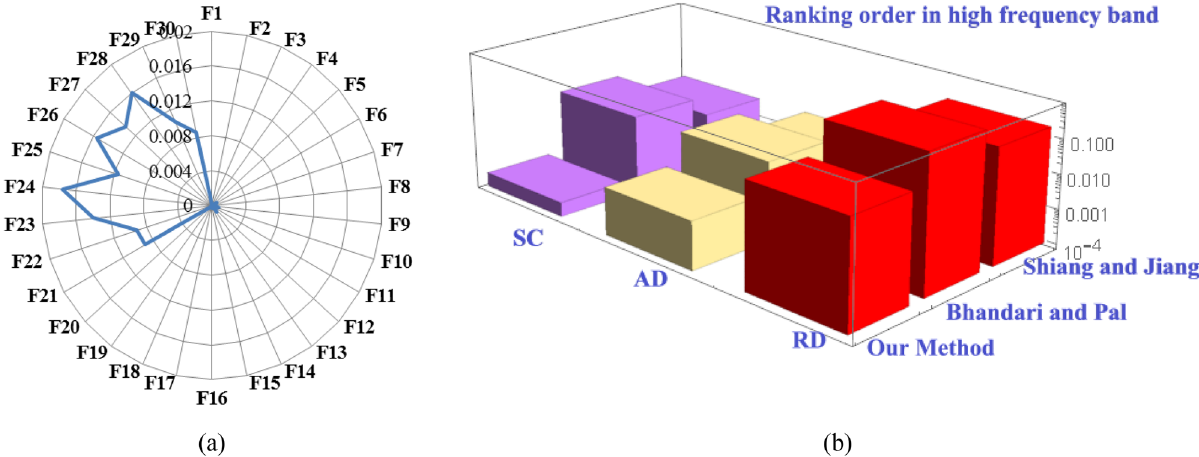
Figure 8. In high frequency range: (a ) FCE measure values for various faults types (b) Comparison sum of measure values of the Shiang and Jiang method 23 , Bhandari and Pal method 23 and the proposed